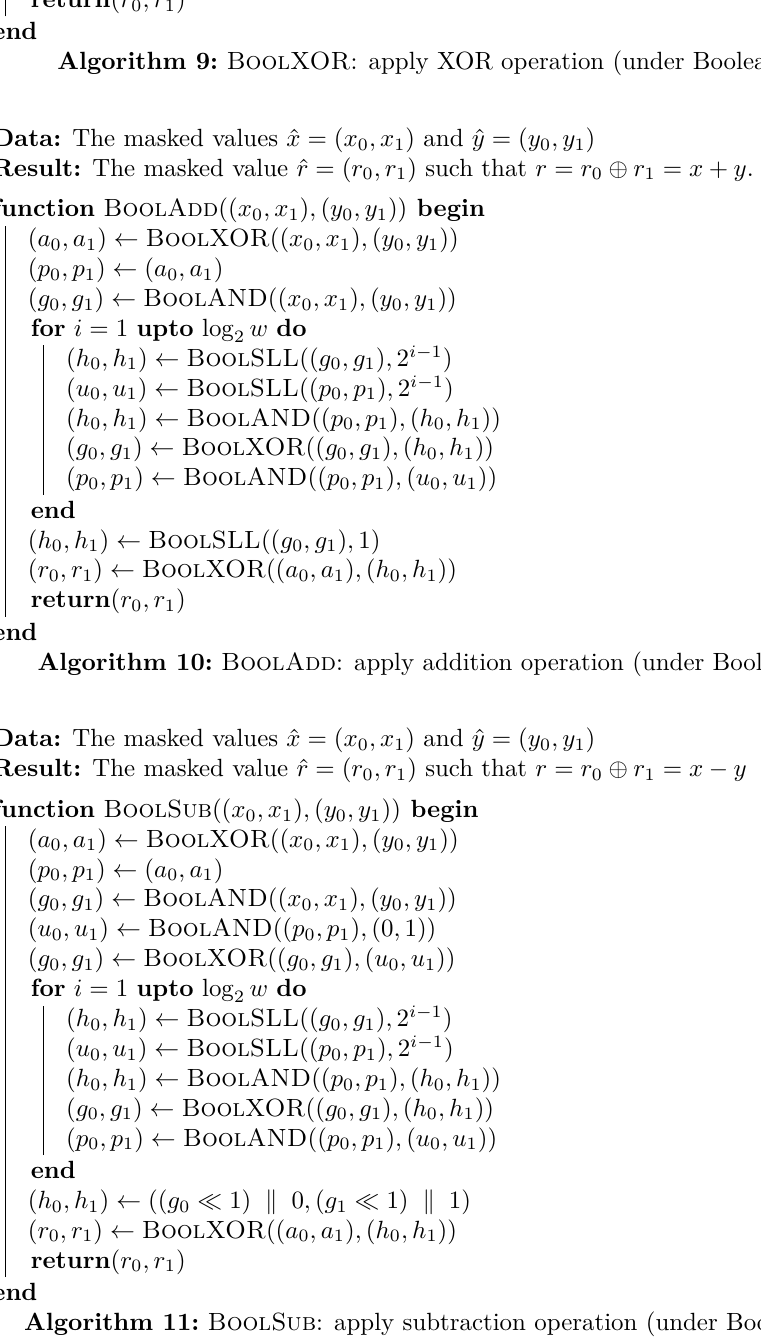
Algorithm 9: BoolXOR : apply XOR operation (under Boolean masking).